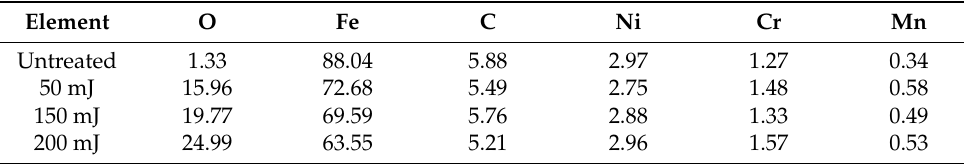
Figure 6. EDS morphologies after different energy treatments. ( a ) base material; ( b ) 50 mJ; ( c ) 150 mJ; ( d ) 200 mJ. Table 3. Elemental content (wt.%).